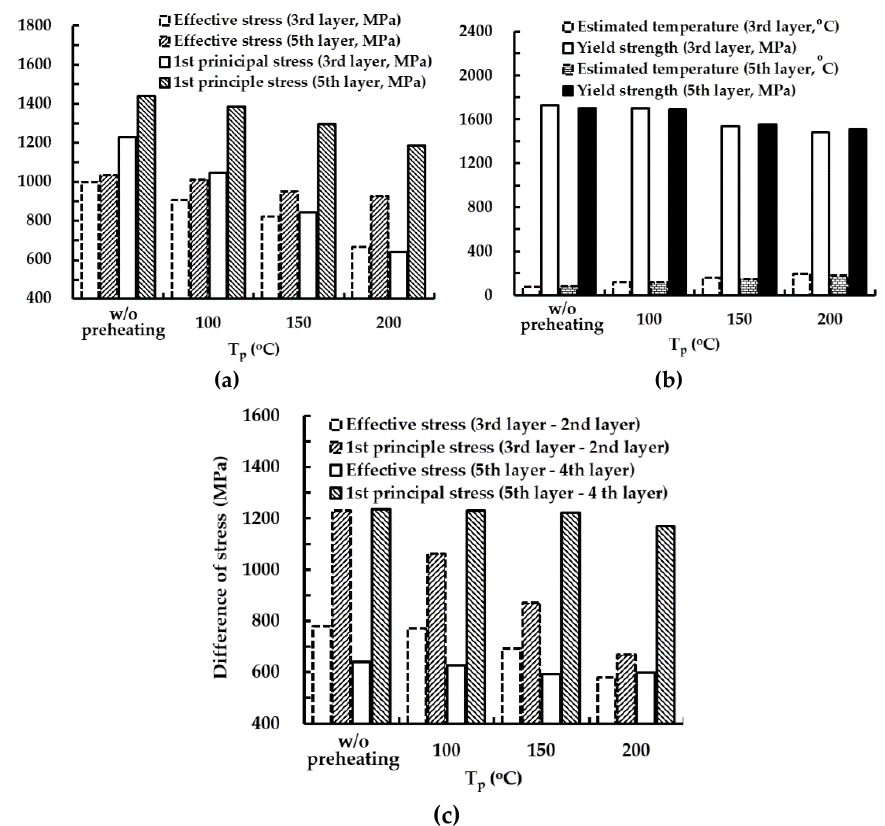
Figure 19. Effects of preheating temperatures on residual stress and yield strength corresponding to the estimated temperature at the location of the maximum stress for a low layer deposition: ( a ) residual stresses; ( b ) yield strengths corresponding to the estimated temperature; ( c ) difference of residual stress.